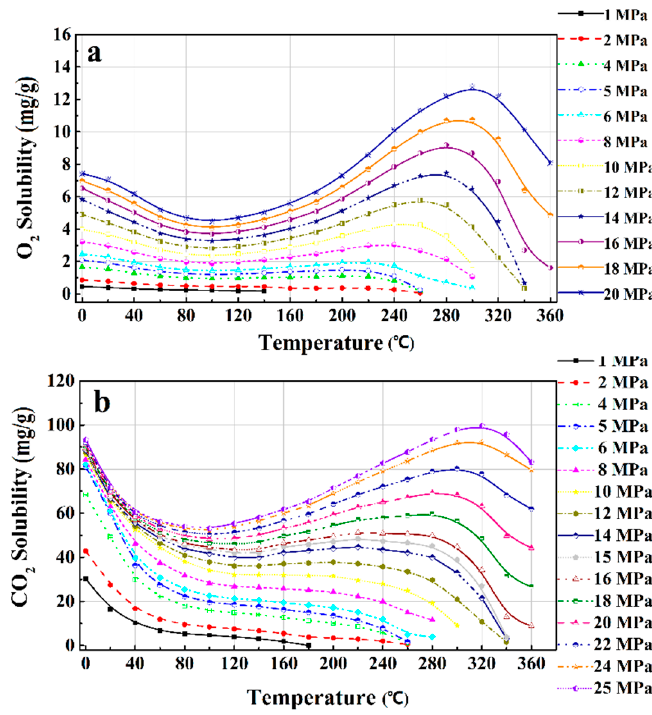
Figure 1. The solubility of oxygen ( a ) and carbon dioxide ( b ) in the high-pressure